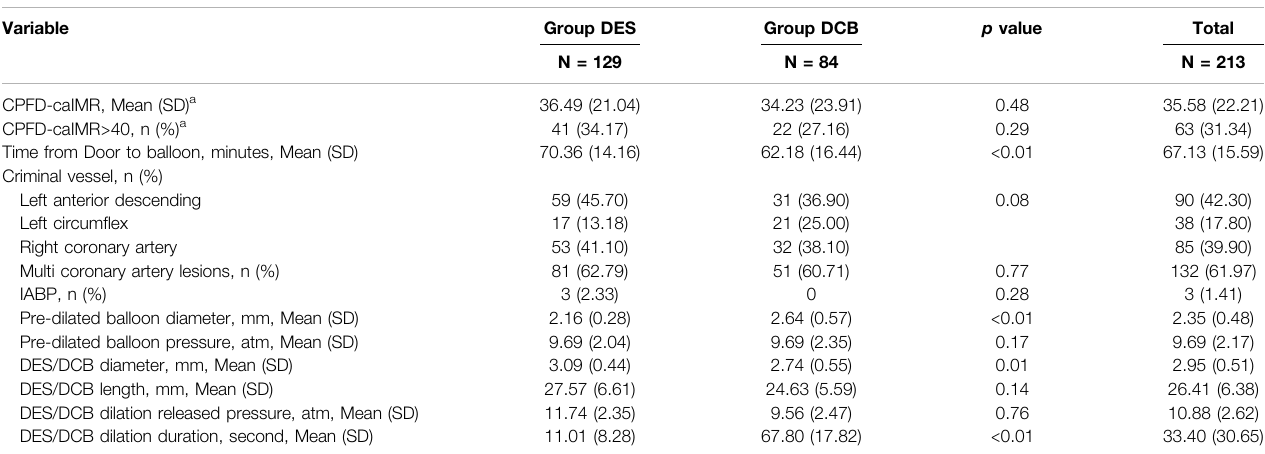
TABLE 2 | Characteristics of PPCI process of the study